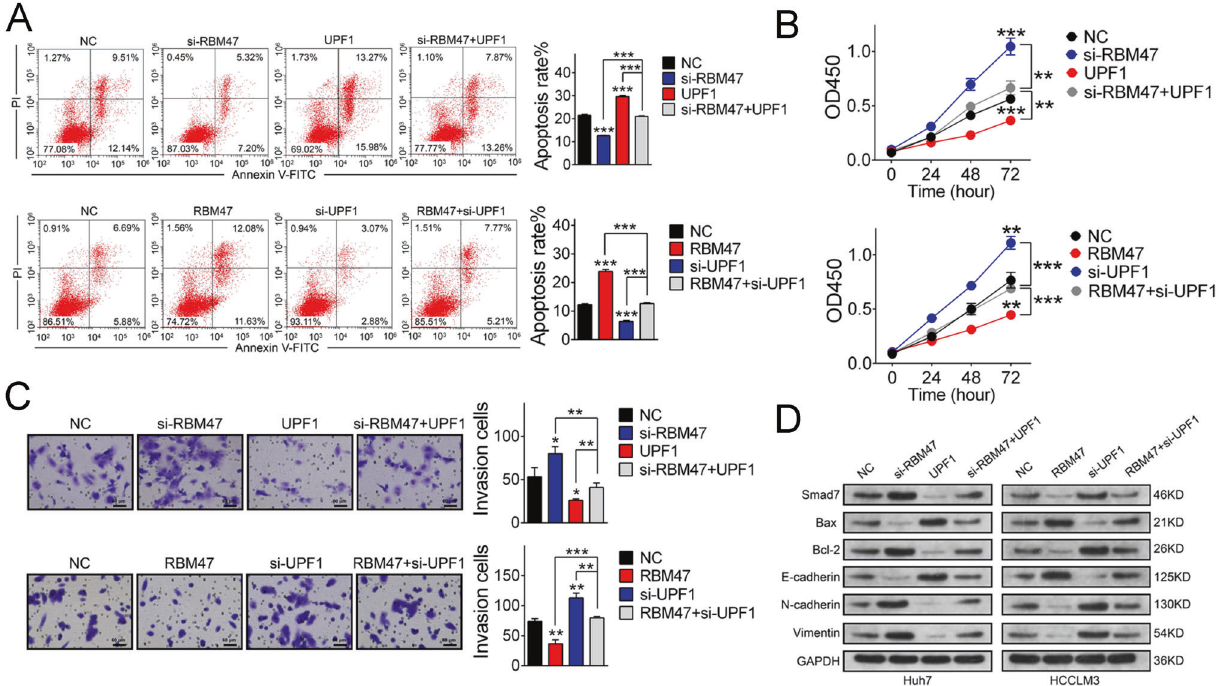
Fig. 5 RBM47 inhibited HCC through regulating UPF1. A – C Flow cytometric analysis, CCK-8 assay, and Transwell assay (bar = 60 μ m) after RBM47 knock down and UPF1 upregulation in Huh7 cells, or enhancing RBM47 and silencing UPF1 in HCCLM3 cells. Error bars are SD ( n = 3). D Rescue experiments of effects of RBM47 on target genes regulated by UPF1 by western blotting. Error bars are SD ( n = 3). * P < 0.05, ** P < 0.01, *** P <